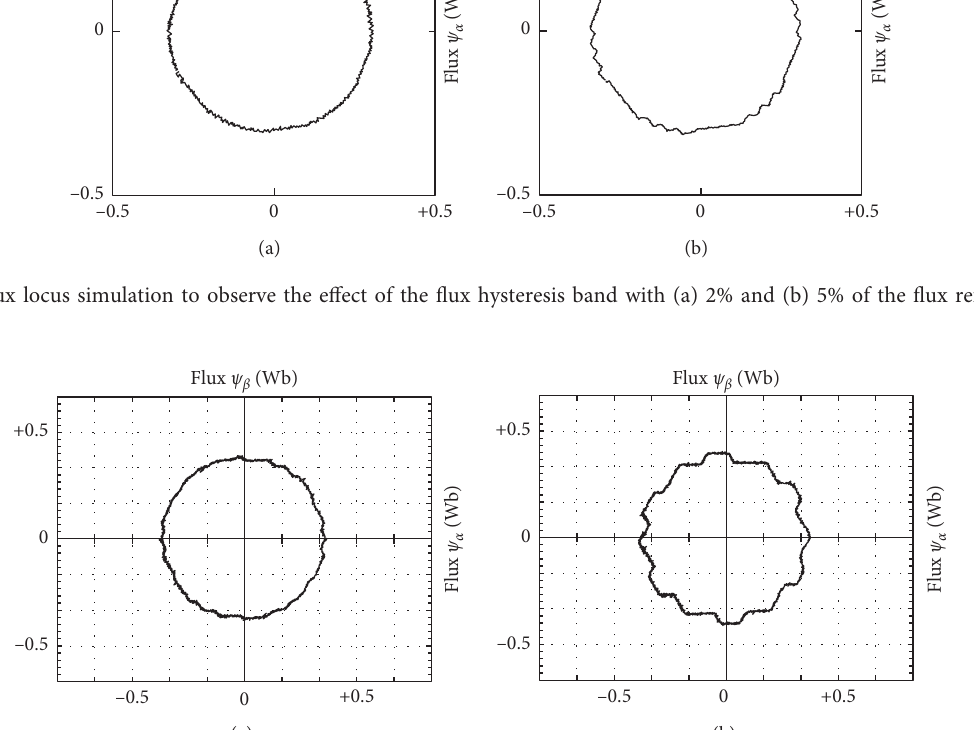
Figure 11: Flux locus on the experimental output to observe the effect of the flux hysteresis band with (a) 2% and (b) 5% of the flux reference value.